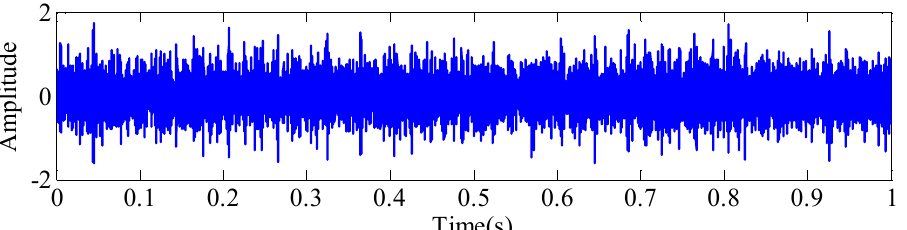
Figure 12. Manual selection of the signal segment of 2 s to construct the singular value decomposition and noise reduction signal of the Hankel matrix.